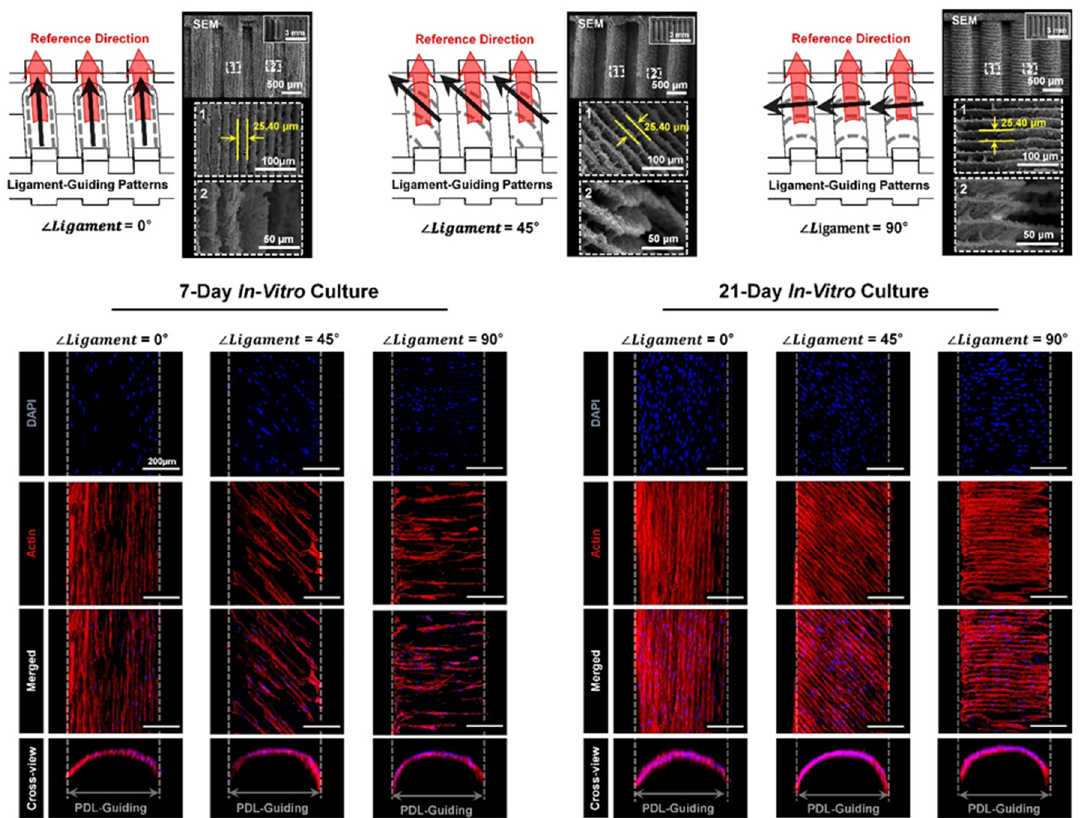
Figure 4. The scanning electron microscopic (SEM) images of micro-groove patterns on the surface of PDL architectures and fluorescence images of cell alignments in 7- and 21-day in vitro cultures for qualitative assessments. Three different micro-groove patterns facilitated angular organization of human PDL cells in 7- and 21-day cultivations. In particular, the micro-grooved topographies with 25.40 µ m interval showed higher populations of cells as well as maintaining specific cell orientations. Adapted with permission from the reference [8].